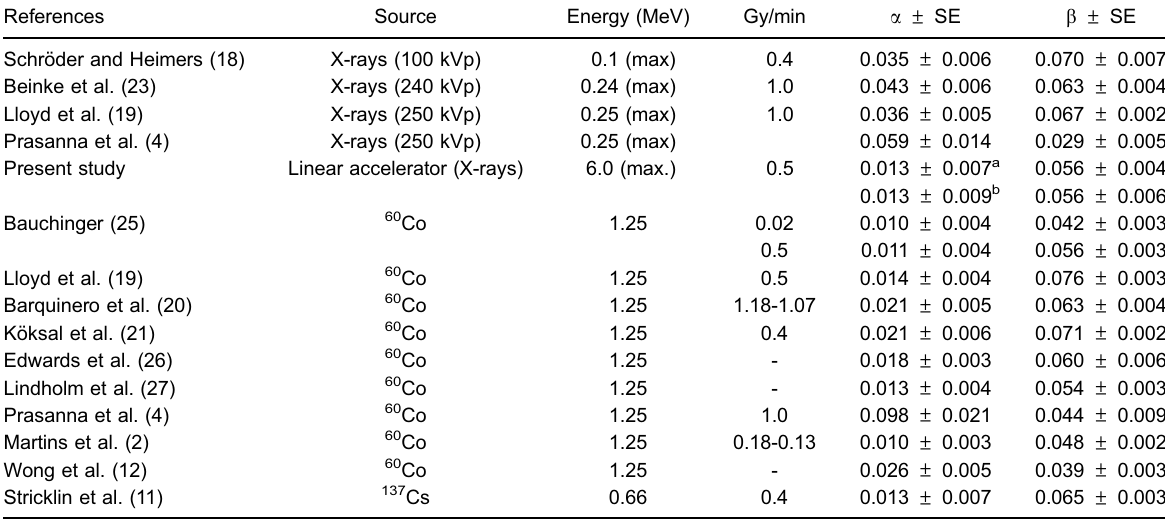
Table 4. Comparison of linear and quadratic yield coef fi cients for dicentric aberrations induced by 100-250 kVp X-rays, gamma- radiation and LINAC X-rays (present study).